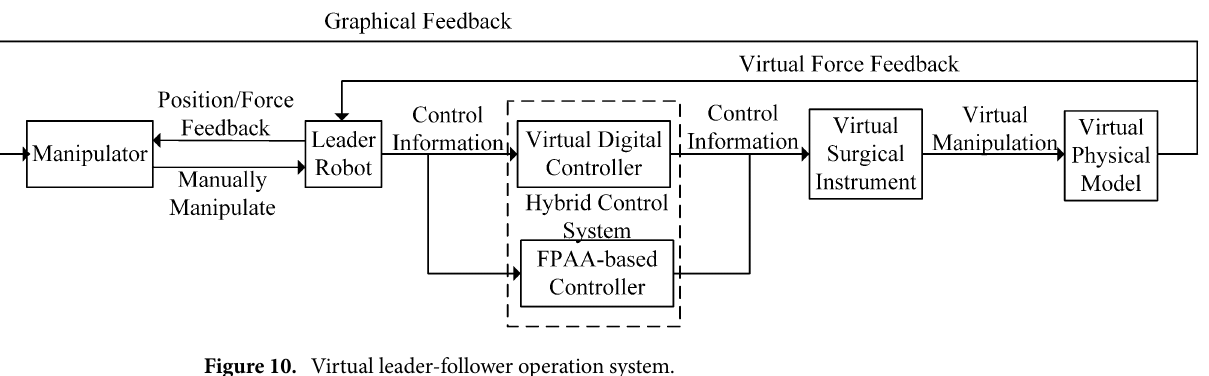
Figure 9. Experimental platform.